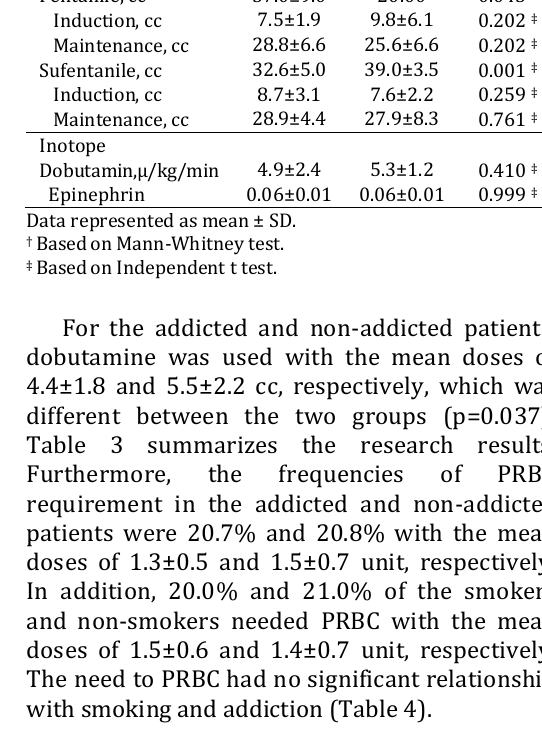
Table 3. Relationship between Addiction and Smoking with operative opium.